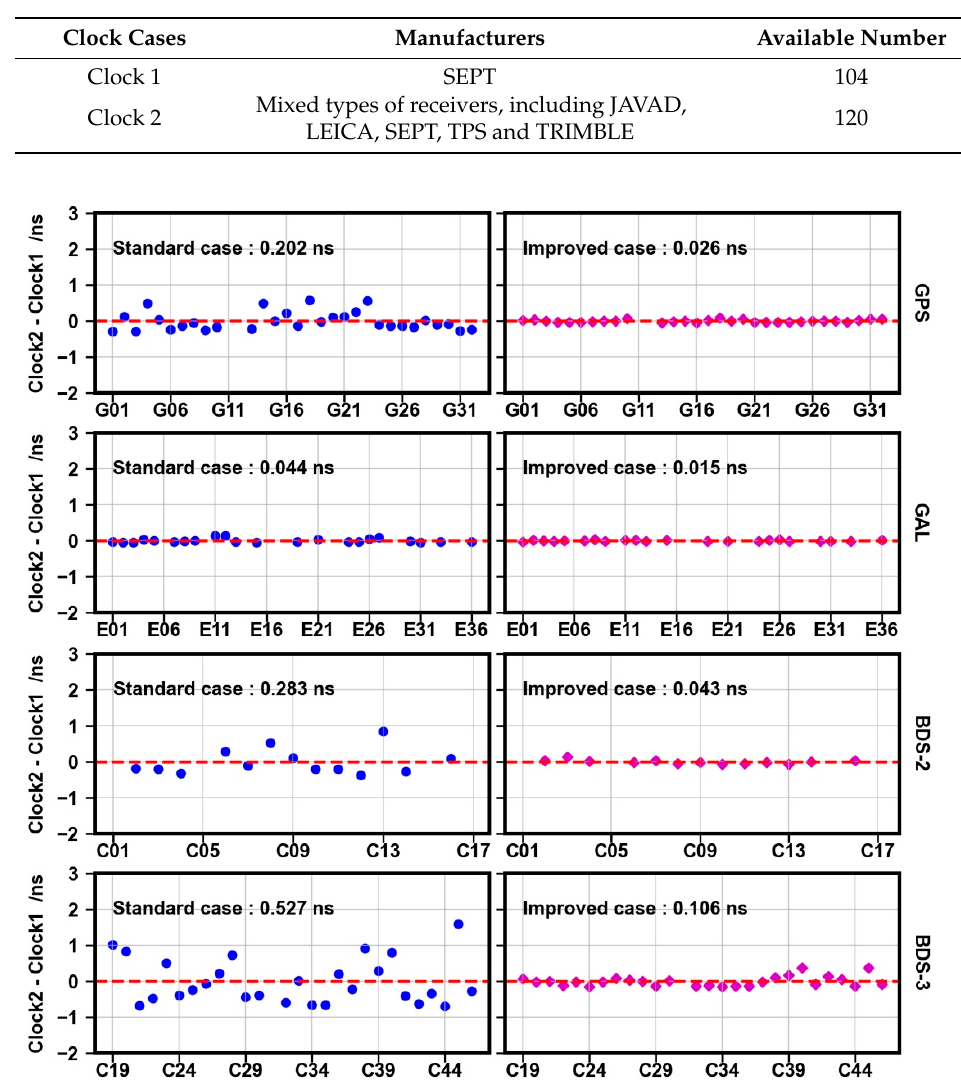
Figure 15. Seven-day average satellite clock differences of GPS, Galileo, BDS-2 and BDS-3 relative to Clock